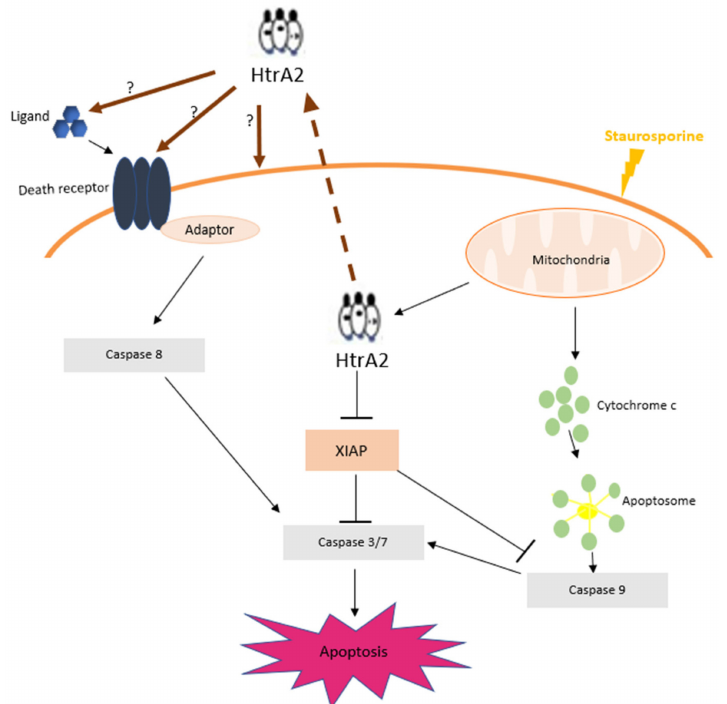
Figure 5. Potential mechanism of HtrA2-mediated release and extracellular induction of apoptosis.